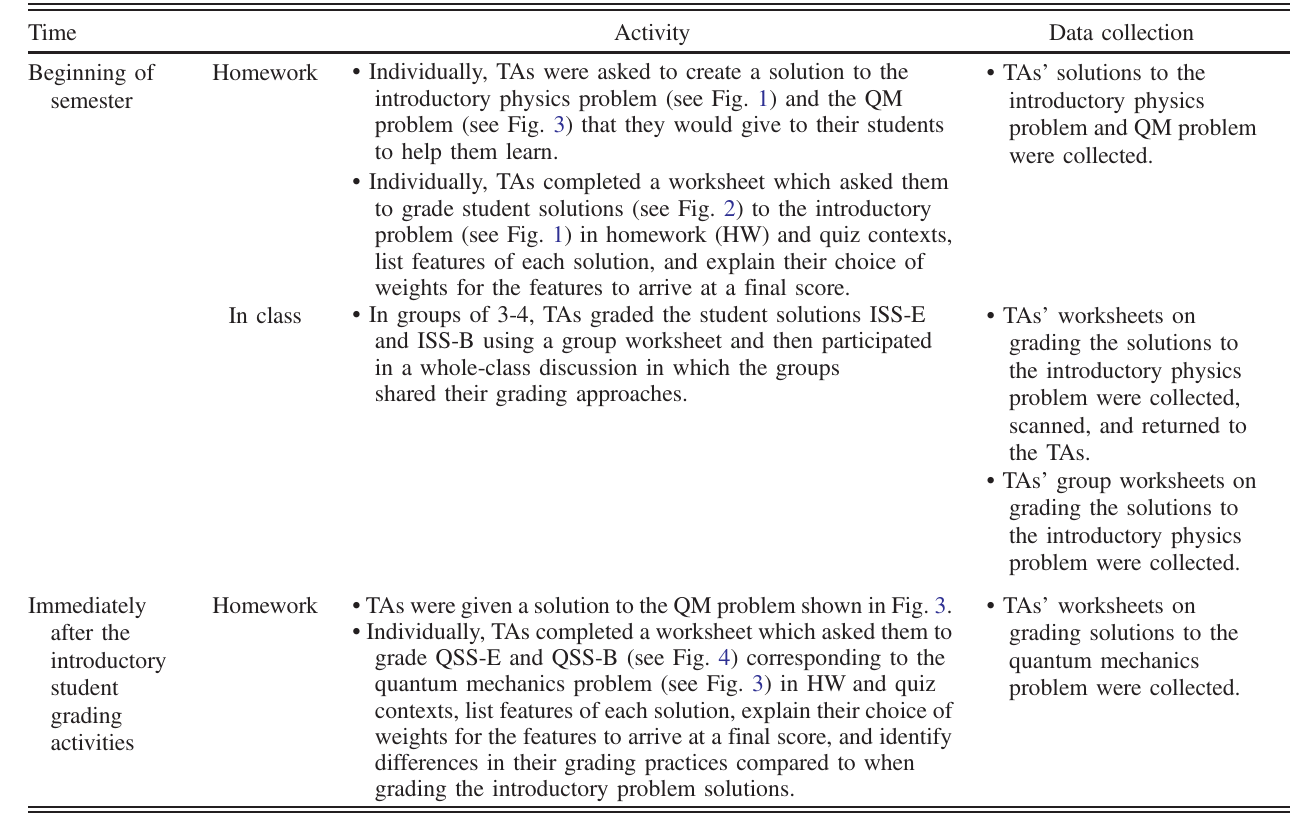
TABLE I. Sequence of TA grading activities. Time Activity